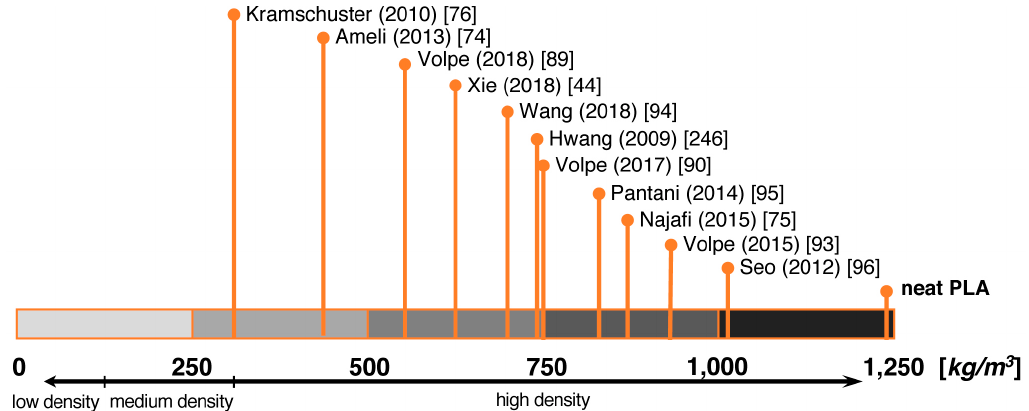
Figure 7. Literature overview of the (lowest) achieved densities in foam-injection-molded PLA.